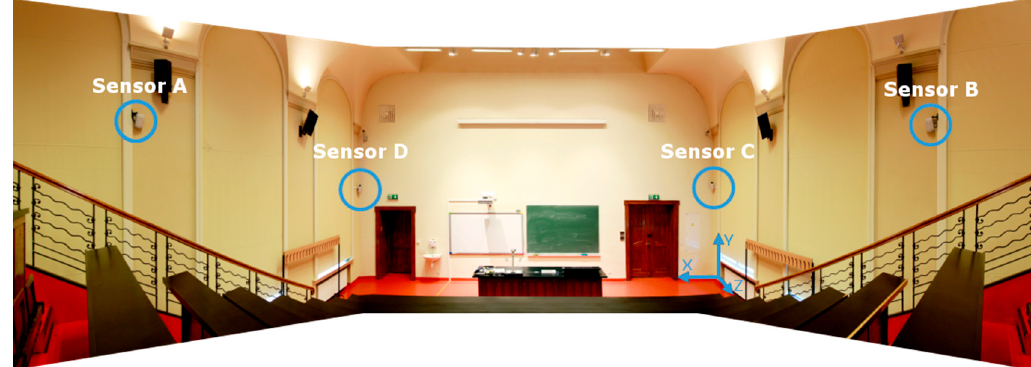
Figure 16. Photo of the indoor environment with mounted LSs and the coordinate system origin.